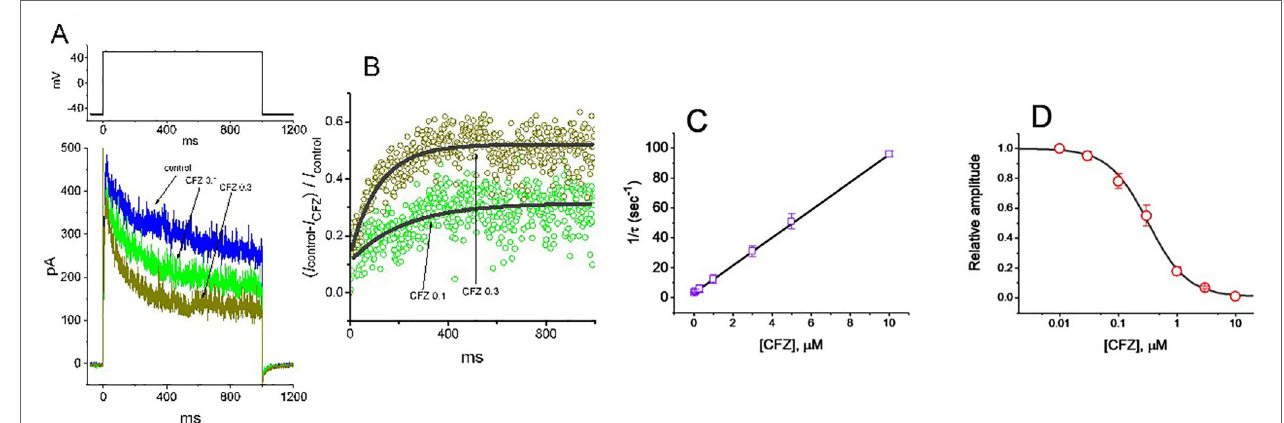
FIGURE 2 | Evaluation of the kinetics of CFZ-induced block of I K(DR) elicited by membrane depolarization in GH 3 cells. The I K(DR) established by depolarizing pulse from −50 to +50 mV with a duration of 1 s (indicated in the upper part of (A)) was measured as cells were exposed to different CFZ concentrations. In (A) , representative I K(DR) traces was obtained in the absence (control) and presence of 0.1 μM CFZ (CFZ 0.1) or 0.3 μM CFZ (CFZ 0.3). In (B) , the time courses of relative block of I K(DR) by 0.1 μM CFZ (CFZ 0.1) and 0.3 μM CFZ (CFZ 0.3) were well fitted by single exponential with a value of 181 and 91 ms (indicated by the smooth curves). The relative block (i.e., ( I control− I CFZ )/ I control ) was evaluated by dividing the CFZ-sensitive current by the current taken from the control (i.e., in the absence